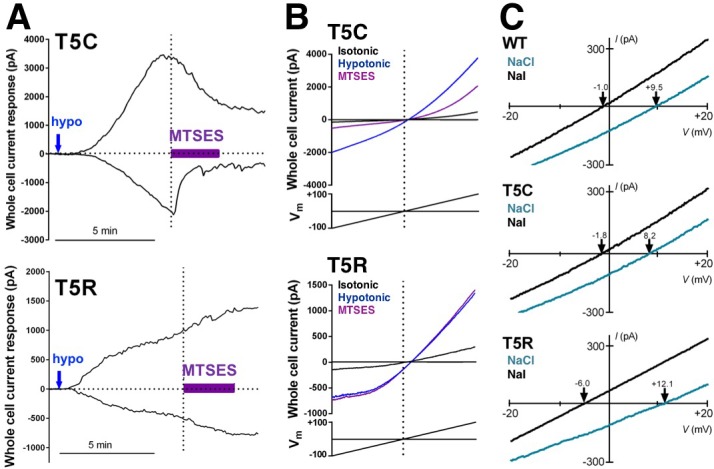
Representative data from cells expressing mutations in SWELL1 at T5 in the unresolved N-terminal region in heteromeric VRAC.(A,B) Representative examples of whole cell currents tested for sensitivity to the extracellularly applied polar MTS reagent MTSES. (A) MTSES blocks SWELL1-T5C-containing channels (top) but has no effect on T5R-containing channels that are not modifiable by MTS reagents. (B) Whole cell currents induced by hypotonic solution (230 mOsm/kg; blue arrows) in HeLa LRRC8-/- cells heterologously expressing SWELL1-T5C (top) or SWELL1-T5R (bottom) with LRRC8C in a 2:1 ratio (0.8 and 0.4 γ/ml). MTSES (purple bar, 3.33 mM) strongly reduced T5C-but not T5R-mediated currents in a manner consistent with covalent modification since reversibility of the T5C block was not observed during washout. Representative currents elicited by voltage ramps from −100 mV to +100 mV are shown (black, before; blue, in hypotonic solution before MTSES; purple, during MTSES). (C) Representative leak subtracted whole cell ramp-induced currents elicited by hypotonic solutions (230mOsm/kg) containing either 88 mM NaCl/10 mM HEPES (green traces) or 88 mM Na-Iodide/10 mM HEPES (black traces) from HeLa LRRC8-/- cells overexpressing WT, T5C or T5R mutants together with LRRC8C at 2:1 ratio. Bianionic solutions described in Qiu et al. (2014) were used to determine relative permeability (PI/PCl).